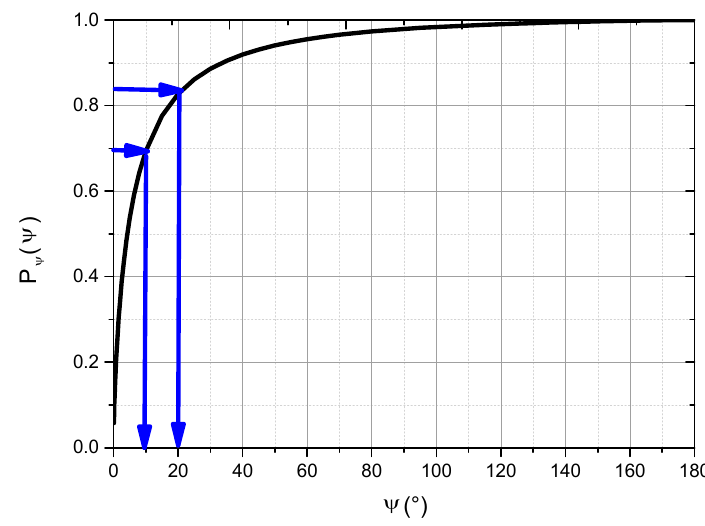
Figure 2. A cdf of Fournier-Forand phase function as tabulated using Equation (4).